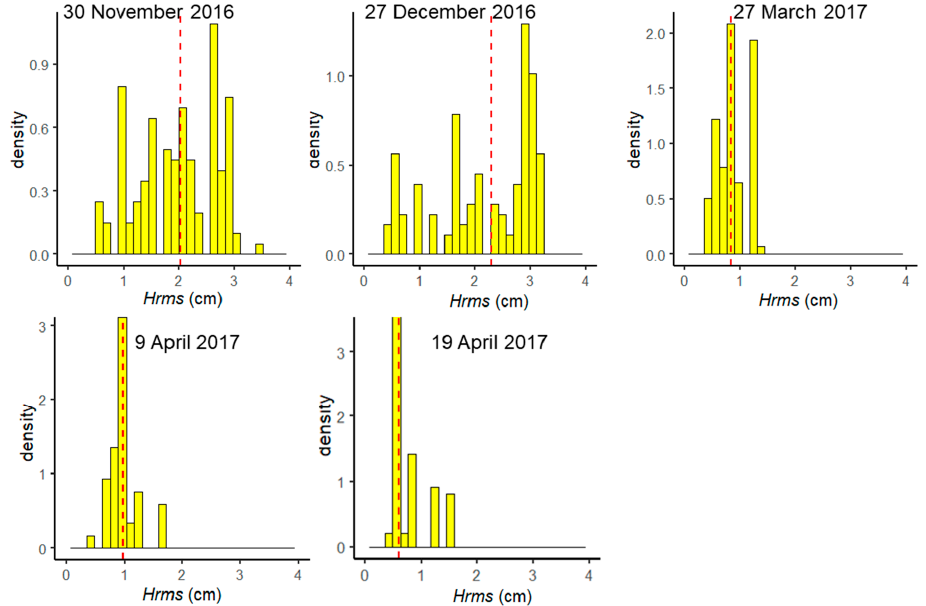
Figure 5. Histograms of Sentinel-1 (S1)-derived root mean square surface height (Hrms) values obtained from Baghdadi et al. (2018) [31] at the soil sample locations for five dates (red line: median value).